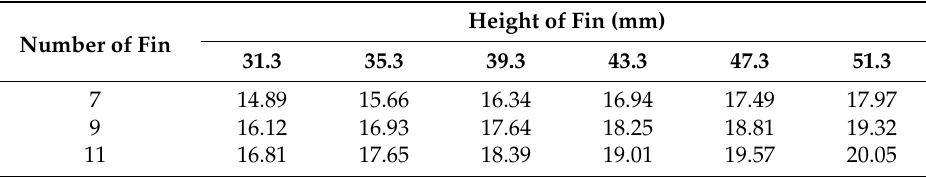
Table 1. Temperature difference between heating and cooling parts ( ◦ C).